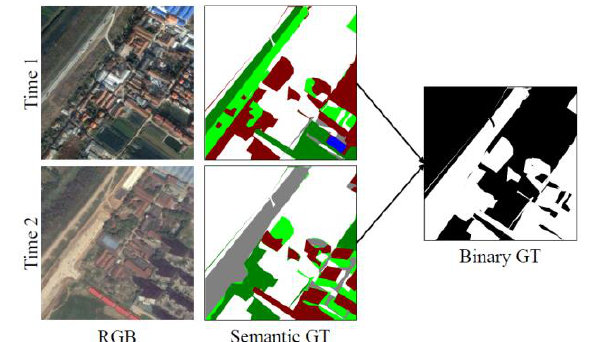
Figure 3. Converting semantic ground truth to binary ground